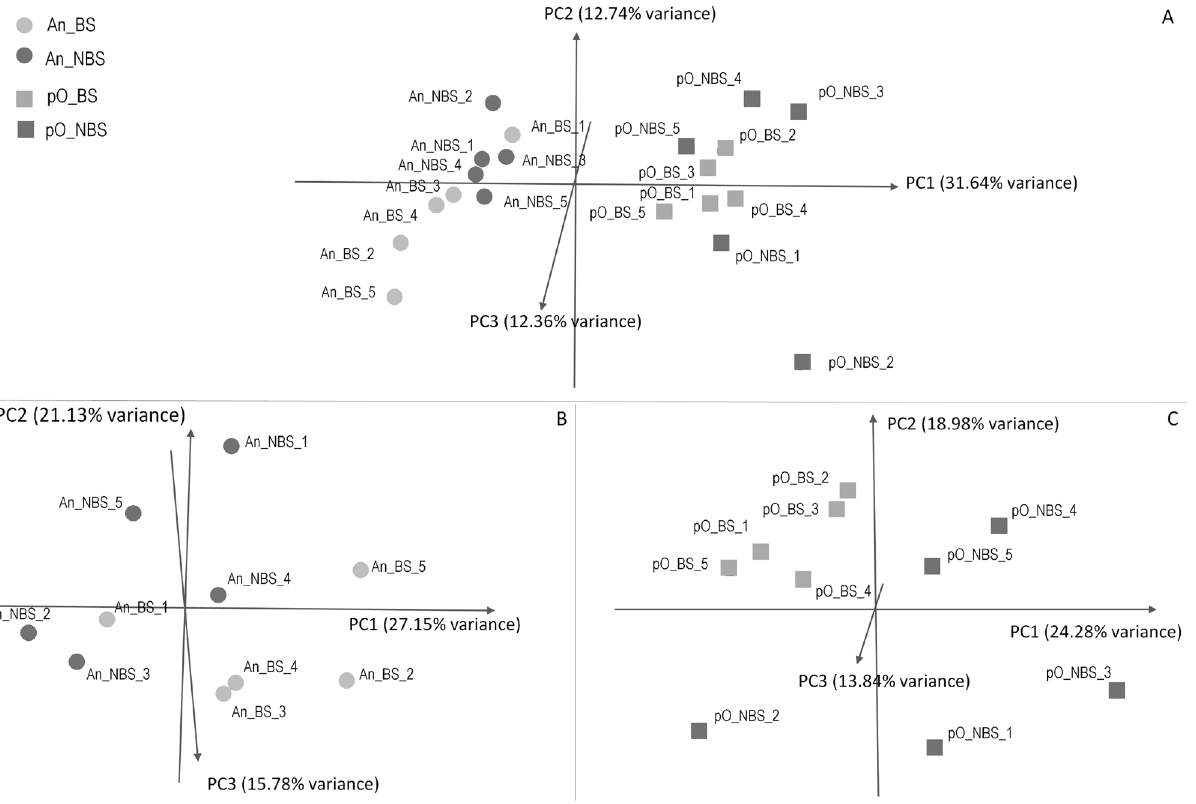
Figure 2. Principal Component Analysis (PCA) for: ( A ) 317 miRNAs counted in all Antral (An) and preovulatory (pO) samples, B) 467 miRNAs counted in all An samples and ( C ) 322 miRNAs counted in all pO